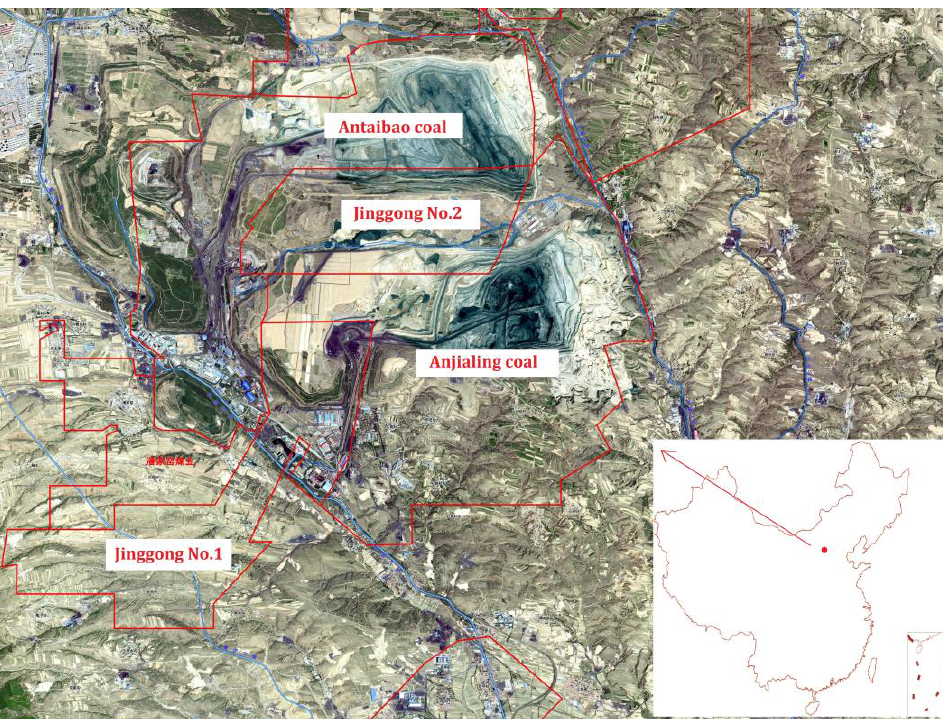
Figure 1. Coal mine distribution map of the study area. The ATB region is adjacent to the AJL region, and their water supply systems have